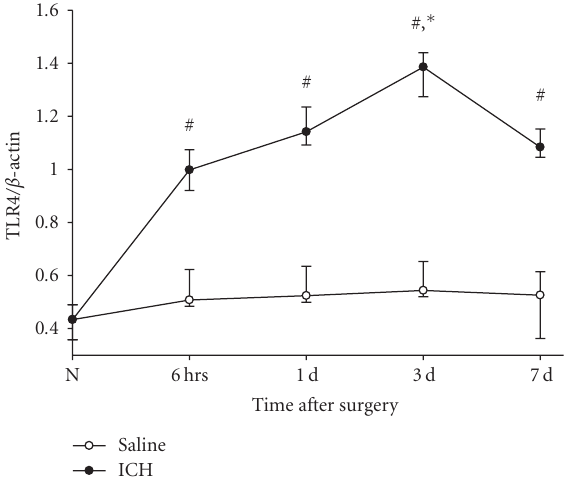
Figure 1: The temporal changes of TLR4 mRNA in brain tissue after ICH . TLR4 mRNA levels were detected by Rt-PCR. The abundance of TLR4 mRNA was expressed as the ratio of TLR4 mRNA to β - actin mRNA. As shown in Figure 1, the low level of TLR4 mRNA was observed in normal rat brain tissue. In the saline control group, the TLR4 mRNA slightly increased but was no significantly di ff erent from normal group. However, the TLR4 mRNA after ICH significantly increased starting from 6 hours after ICH ( P < .05), peaked on 3 days after ICH ( P < . 05), and then decreased on 7 days after ICH, but still maintained at a higher level compared with saline control ( P < . 05). #: compared with saline control, P < . 05; ∗ : compared with 6 hours after ICH, P < . 05.